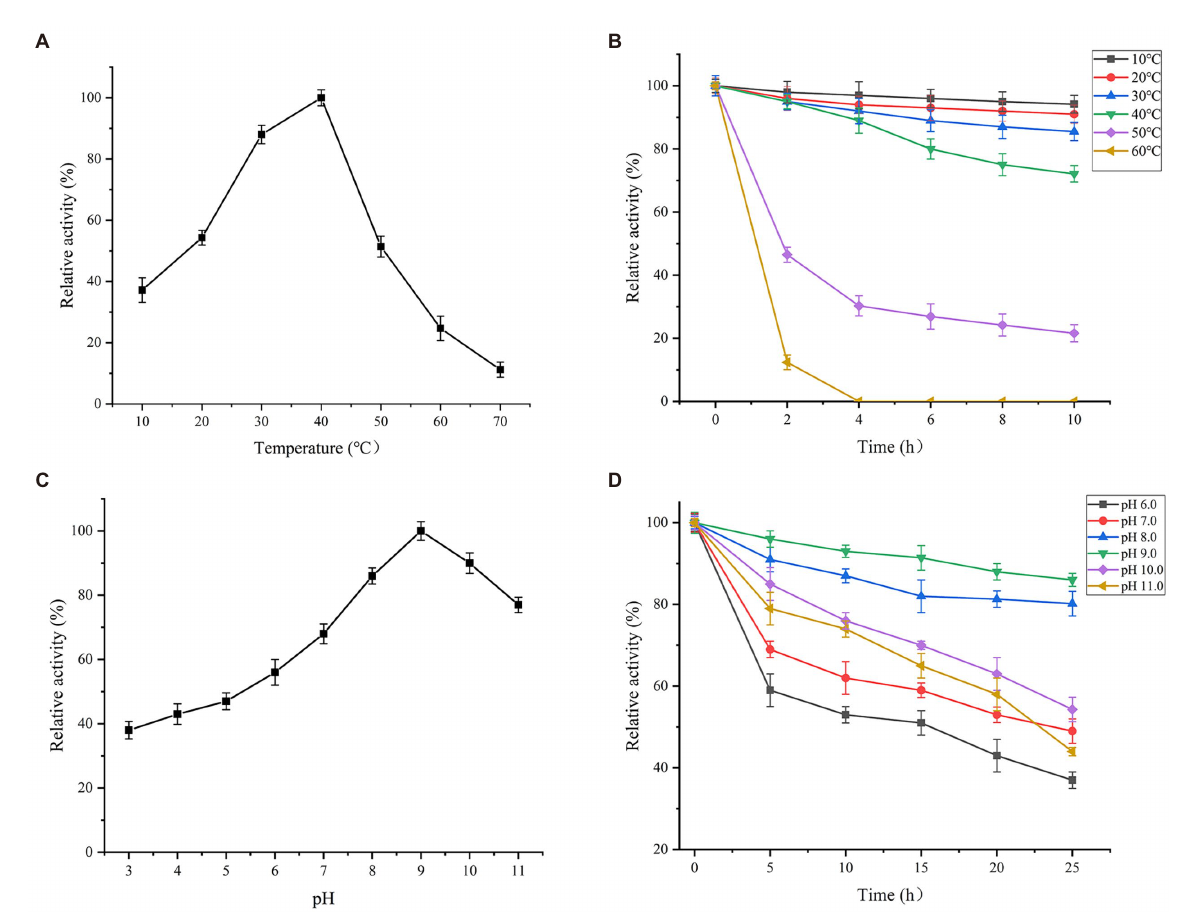
FIGURE 5 Effects of (A) temperature on activity, (B) temperature on thermal stability, (C) pH on activity, and (D) pH on stability of Est882. Symbols: square: 10 ° C. circle: 20 ° C. upward triangle: 30 ° C. downward triangle: 40 ° C. diamond: 50 ° C. left triangle: 60 ° C. Symbols: square: pH 6.0. circle: pH 7.0. upward triangle: pH 8.0. downward triangle: pH 9.0. diamond: pH 10.0. left triangle: pH